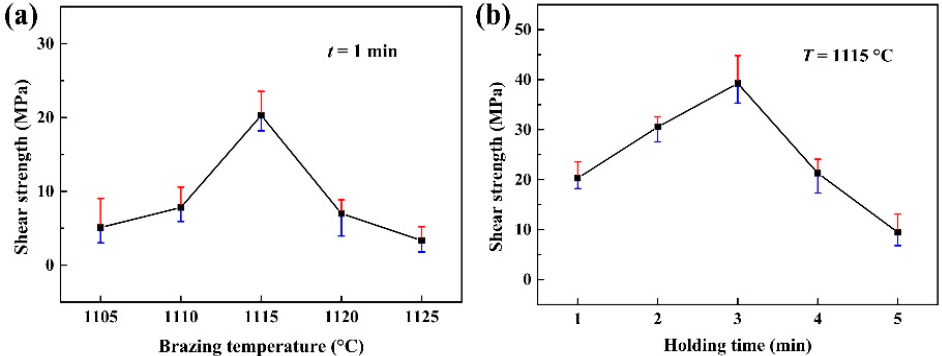
Figure 8. Effect of ( a ) brazing temperature and ( b ) holding time on shear strength of titanium/Au/Al 2 O 3 joints.